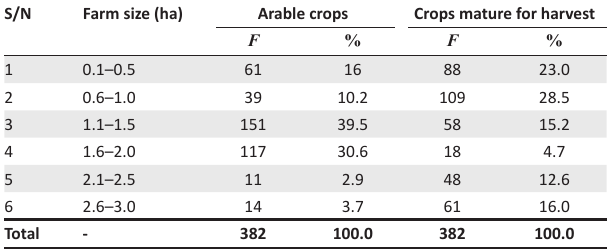
TABLE 3: Arable crops affected in Adamawa State. S/N Farm size